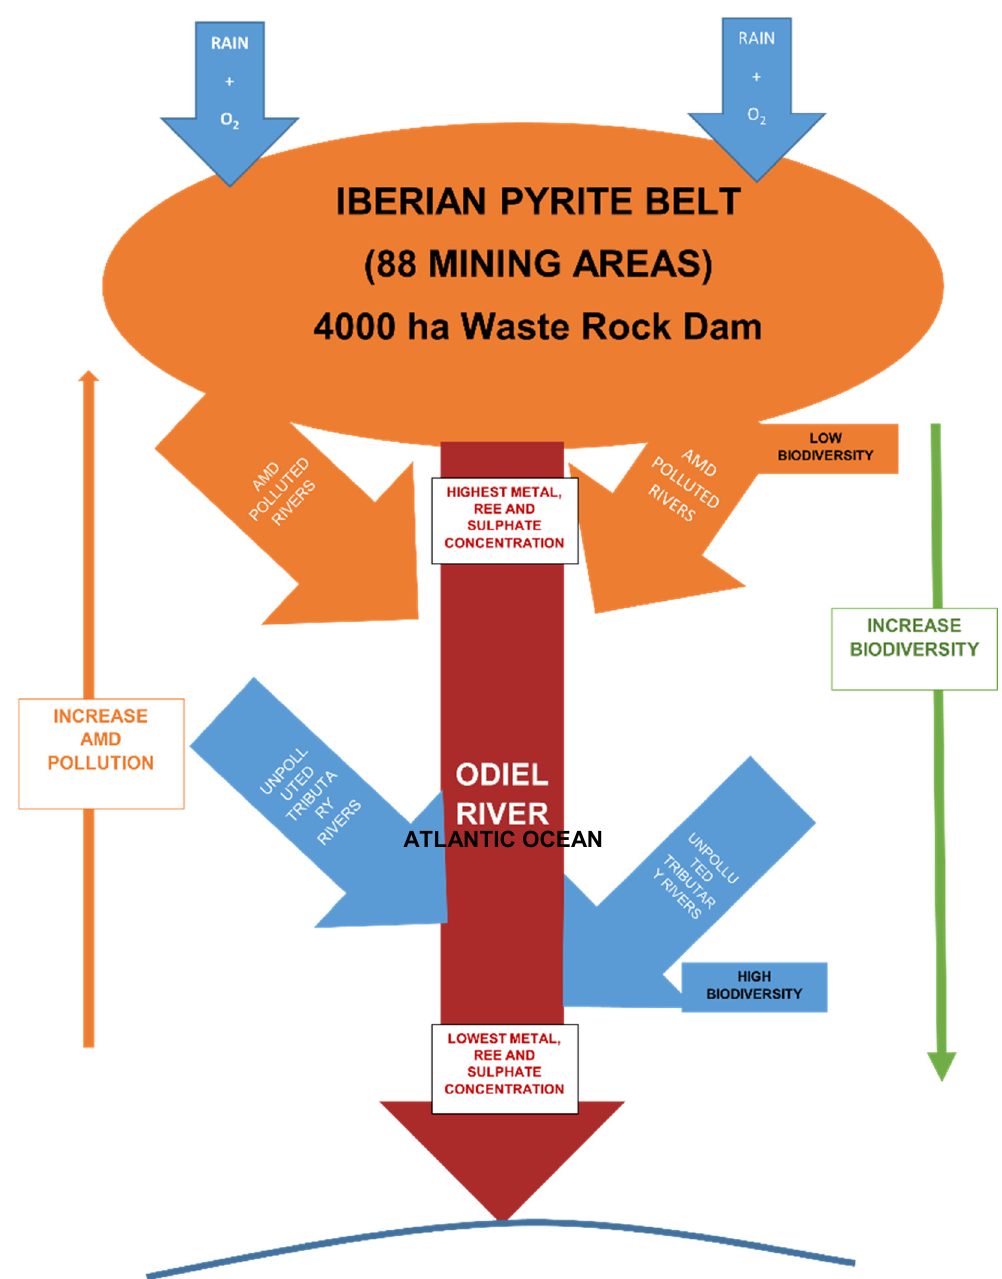
Figure 6. Graphical visualization of pollution degree and biodiversity evolution in the studied river.